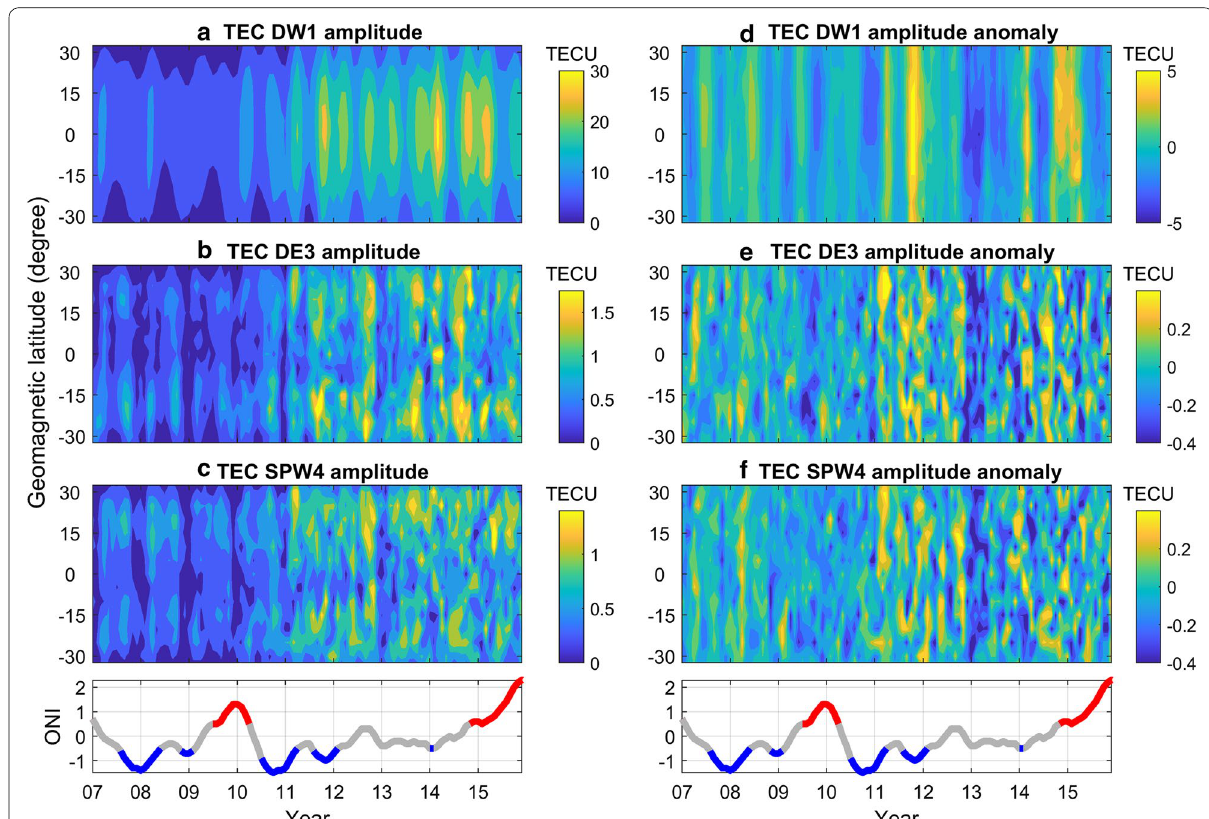
Fig. 1 (Left) Amplitude of the F3/C TEC (top row) diurnal westward wavenumber 1 (DW1), (second row) diurnal eastward wavenumber 3 (DE3), and (third row) stationary planetary wavenumber 4 (SPW4) as a function of time and geomagnetic latitude. The latitudinal and temporal resolutions are 5 ° and 1 month, respectively. (Right) Amplitude anomalies as a function of geomagnetic latitude. The anomaly is defined as by removing the mean annual variation from the detrended time series of tidal/SPW amplitude at each latitude. The bottom panel is the Oceanic Niño Index (ONI). Red and blue (exceeding the threshold of 0.5 °C) on the ONI indicate the ENSO (El Niño–Southern Oscillation) warm and cold ±